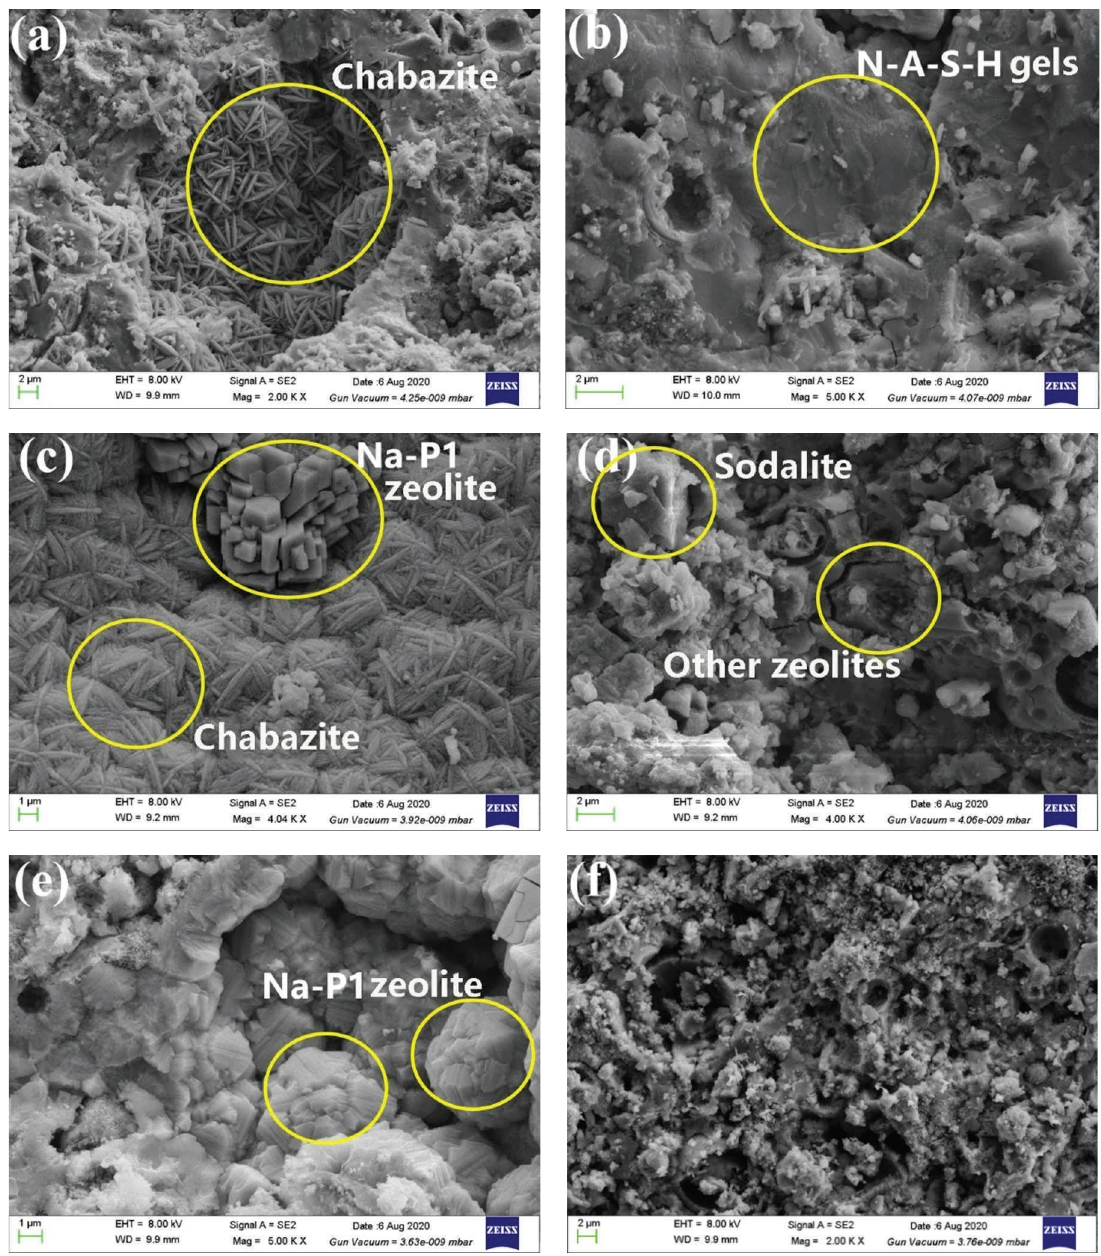
Figure 7: Te SEM images of zeolites and N-A-S-H gels in geopolymers after curing at 90 ° C for 28d. (a) and (b) Sodium hydroxide content of 10%; (c) and (d) sodium hydroxide content of 15%; (e) and (f) sodium hydroxide content of 20%.